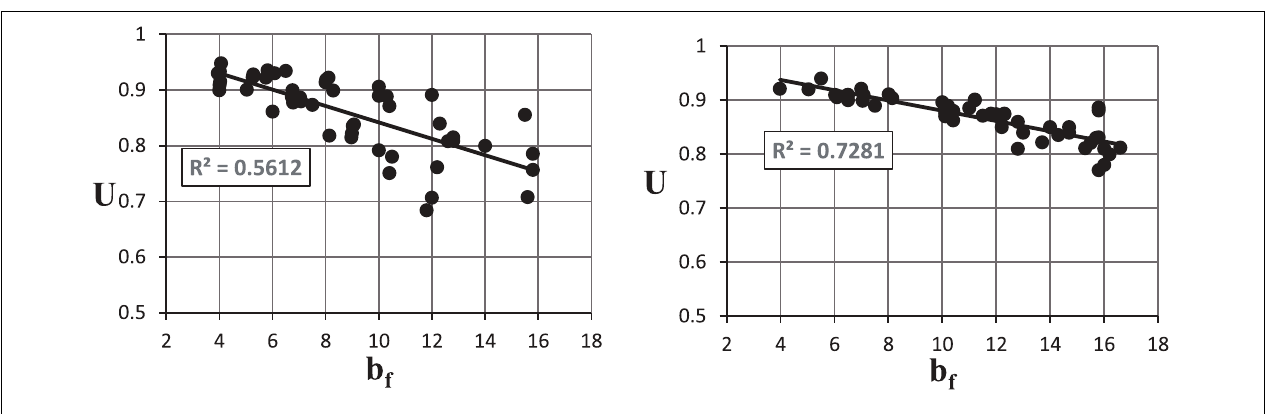
FIGURE 7 | U vs. b f based on FEA for W (left) and WT (right) sections (12 in.